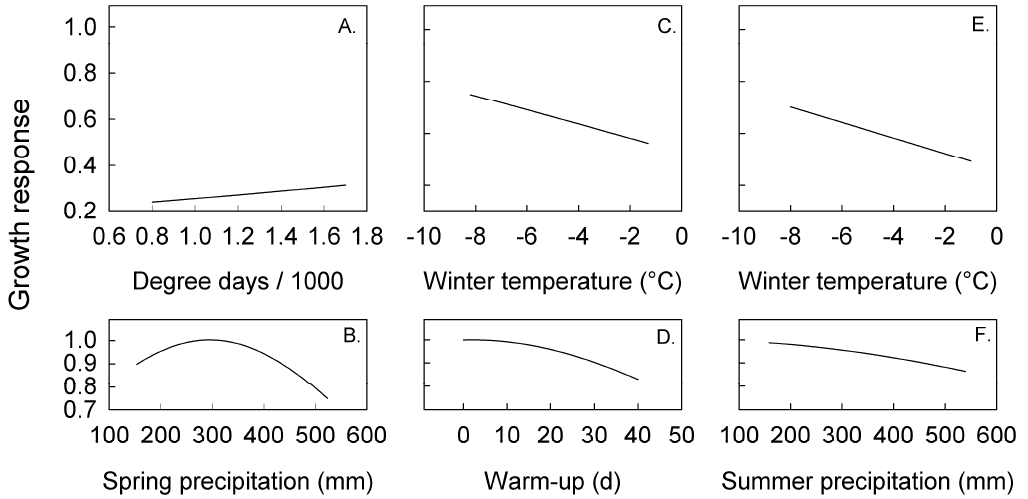
Figure 1. Climate response (fraction of potential growth) of trees inferred from tree ring growth from 1978–2011 in an old-growth hemlock stand on the Helderberg plateau in east–central New York. ( A ) E ff ect of growing temperatures (degree-days) on hemlock growth. ( B ) E ff ect of spring precipitation on hemlock. ( C ) E ff ect of summer temperature on yellow birch growth. ( D ) E ff ect of warm spring days (three-day mean > 5 ◦ C) on yellow birch growth. ( E ) E ff ect of mean winter (December–January–February) temperatures on sugar maple growth. ( F ) E ff ect of summer precipitation on sugar maple